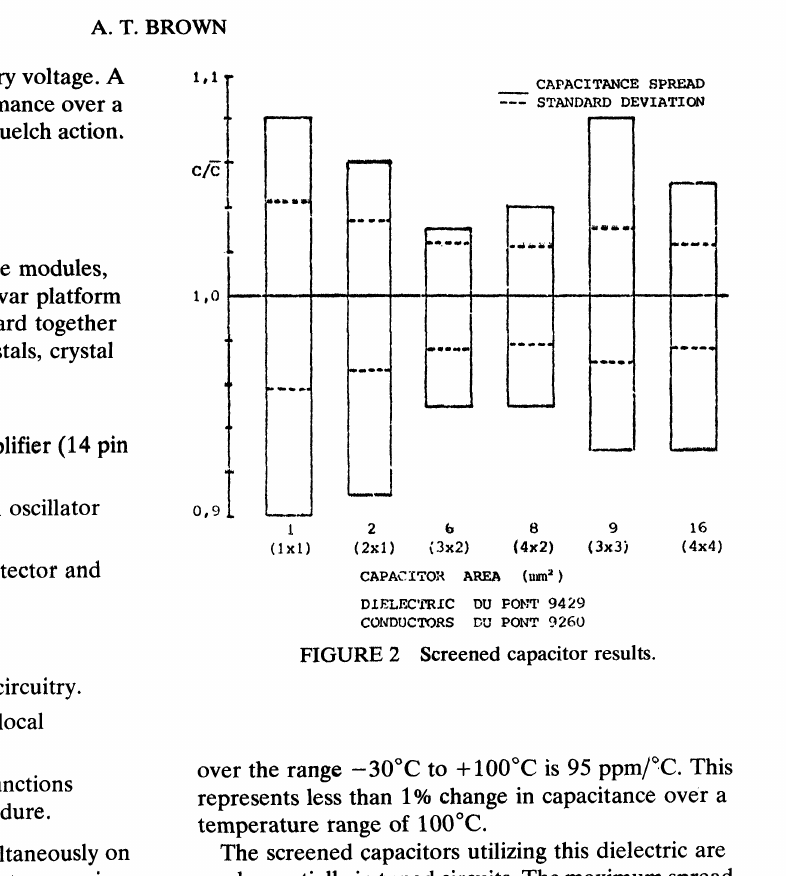
FIGURE 2 Screened capacitor